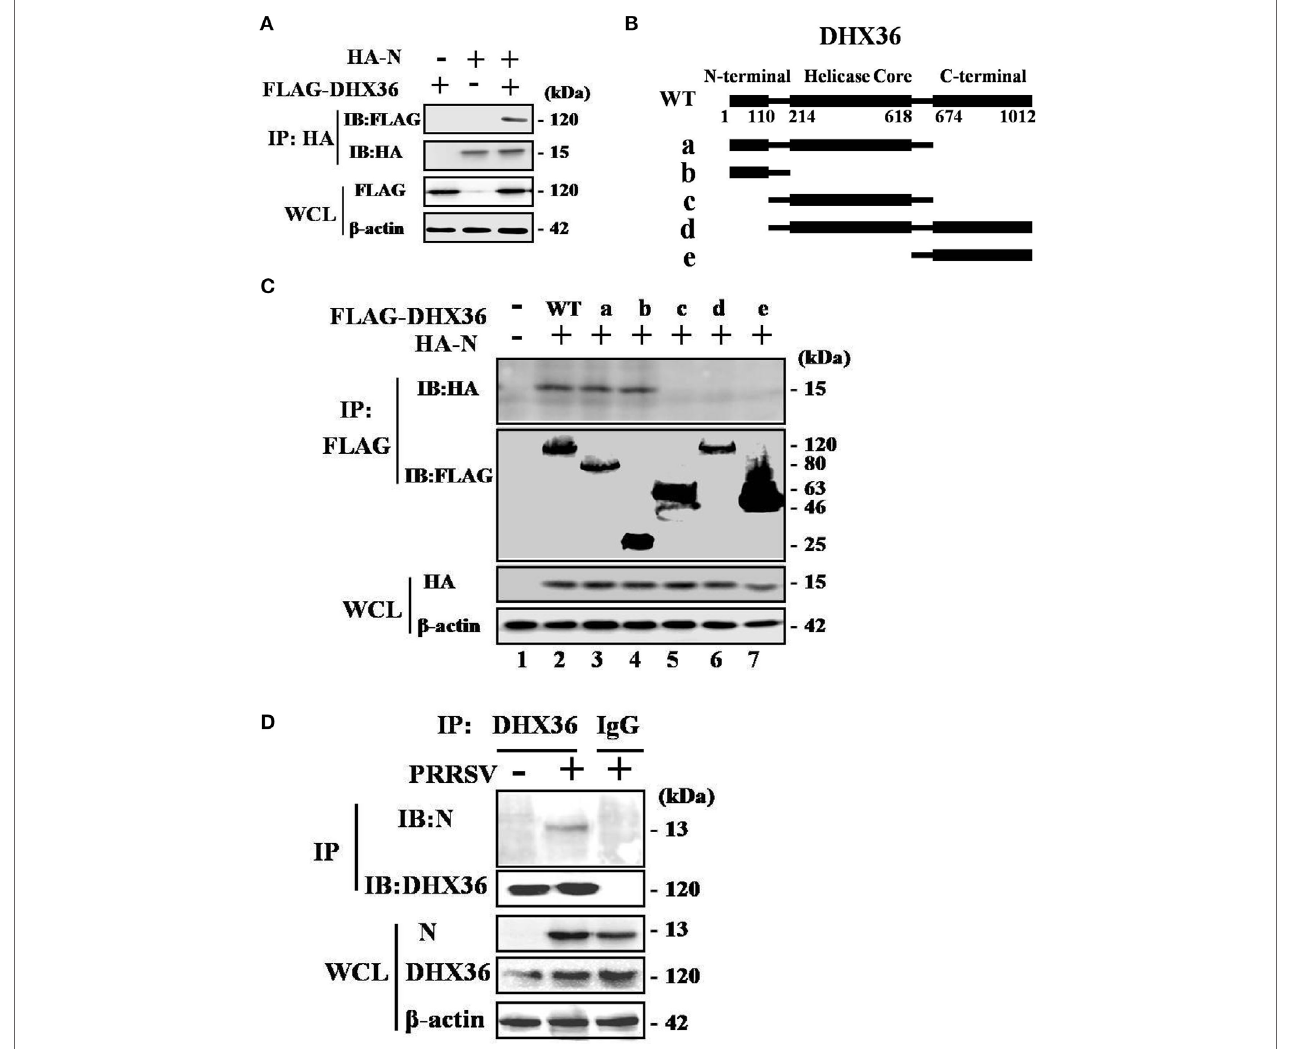
FigUre 7 | Porcine reproductive and respiratory syndrome virus (PRRSV) N protein interacts with DExD/H-box helicase 36 (DHX36). (a) HEK293T cells were co-transfected with expression vectors encoding FLAG-DHX36 and/or HA-N. Cell lysates were co-immunoprecipitated with an anti-hemagglutinin antibody and immunoblotted with an anti-FLAG antibody to assess the interaction between DHX36 and N protein. (B) Schematic representation of DHX36 mutants. Structurally, DHX36 consists of a highly conserved catalytic core (214–618 aa) flanked by ancillary N-terminal region (1–110 aa) and C-terminal region (674–1012 aa), which have been shown to provide substantial substrate specificity through interaction with RNA or proteins. (c) CO-IP and immunoblot analysis of HEK293T cells transfected with deletion mutants of FLAG-DHX36 along with vector for HA-N. (D) Anti-DHX36 immunoprecipitation and immunoblot analysis of extracts from MARC-145 cells infected with PRRSV for 24 h. Cell lysates were also immunoprecipitated with rabbit normal IgG as